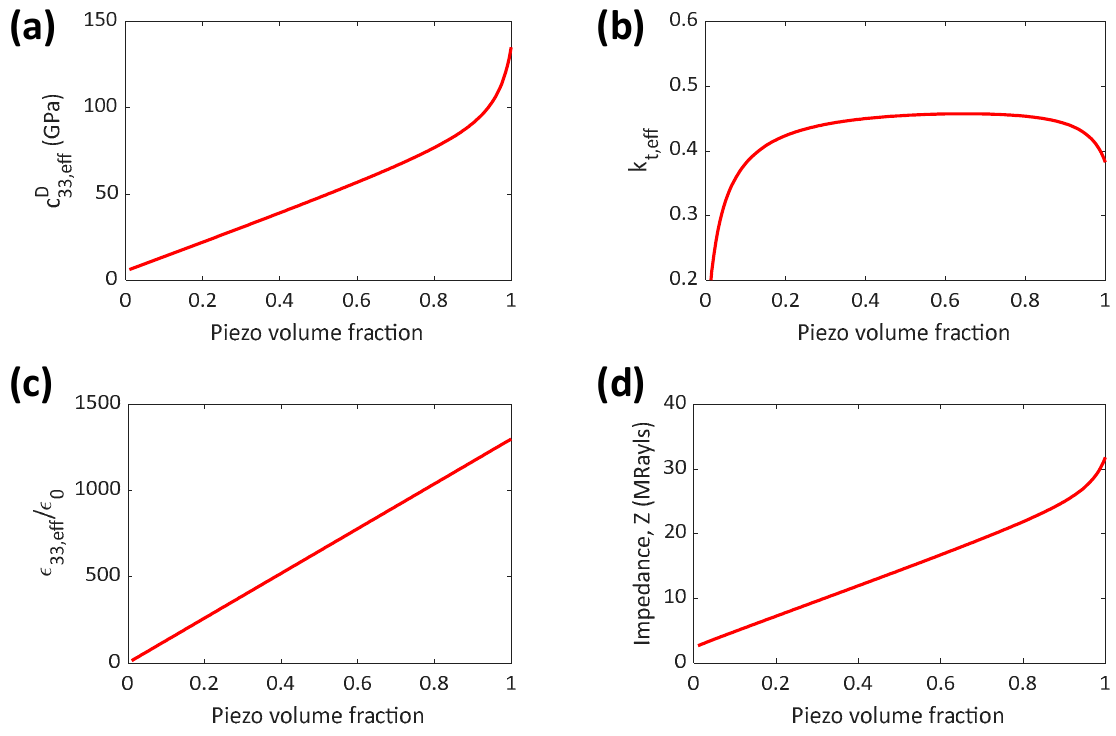
Figure 2. Effective material properties of the PZT-4/epoxy 1–3 composite; ( a ) mechanical stiffness, ( b ) electromechanical coupling, ( c ) dielectric permittivity, and ( d ) acoustic impedance.